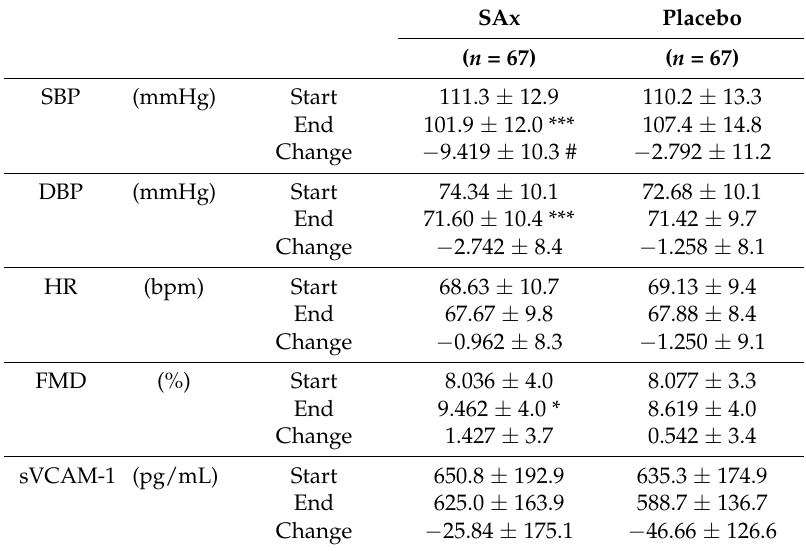
Table 3. Vascular function variables at the start and end of the supplementation and placebo periods. SAx